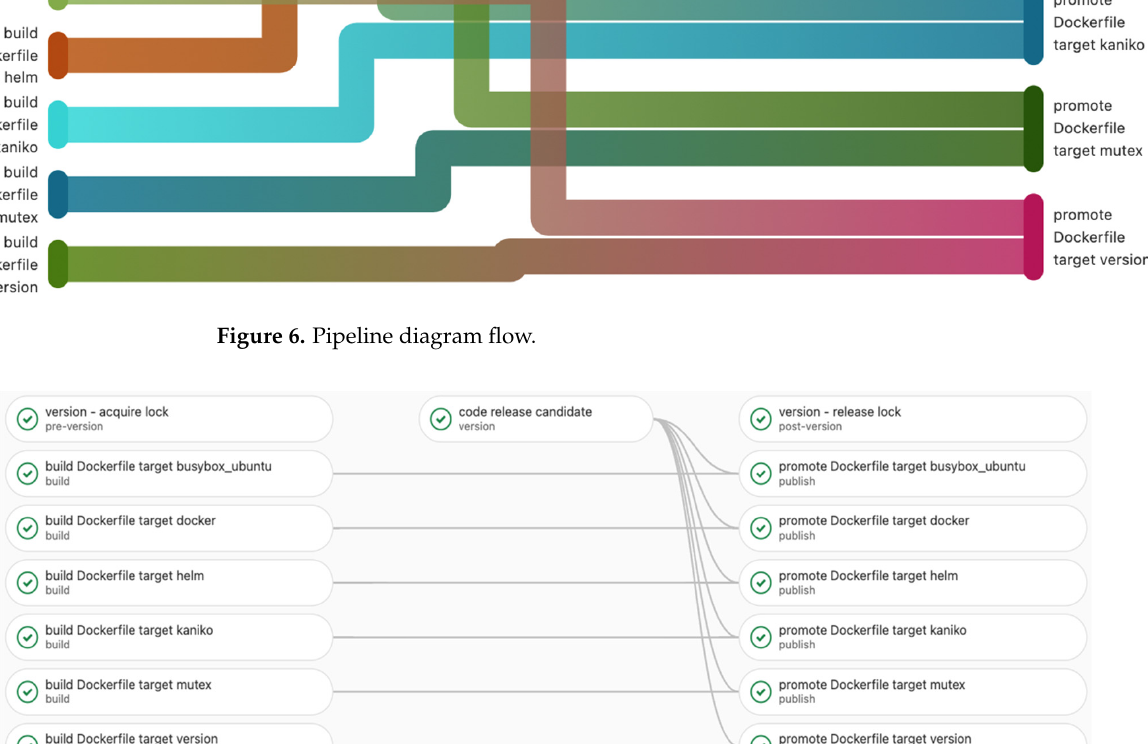
Figure 7. The pipeline diagram flow dependencies.